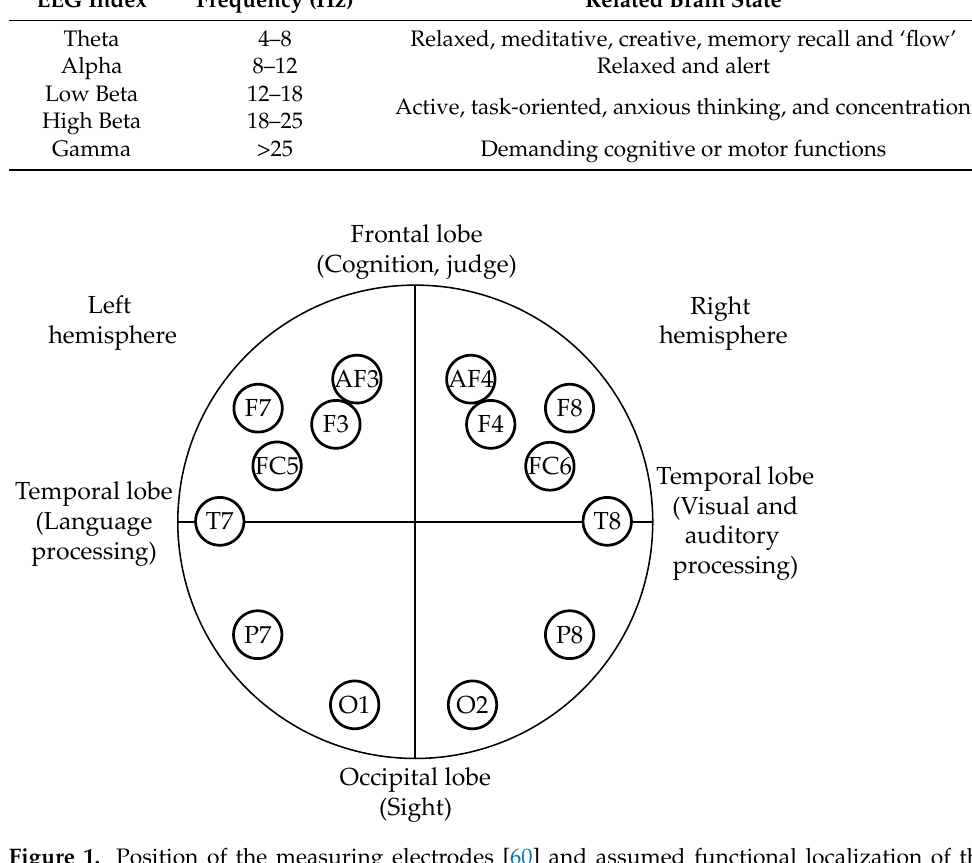
Figure 1. Position of the measuring electrodes [60] and assumed functional localization of the brain [53 – 58].